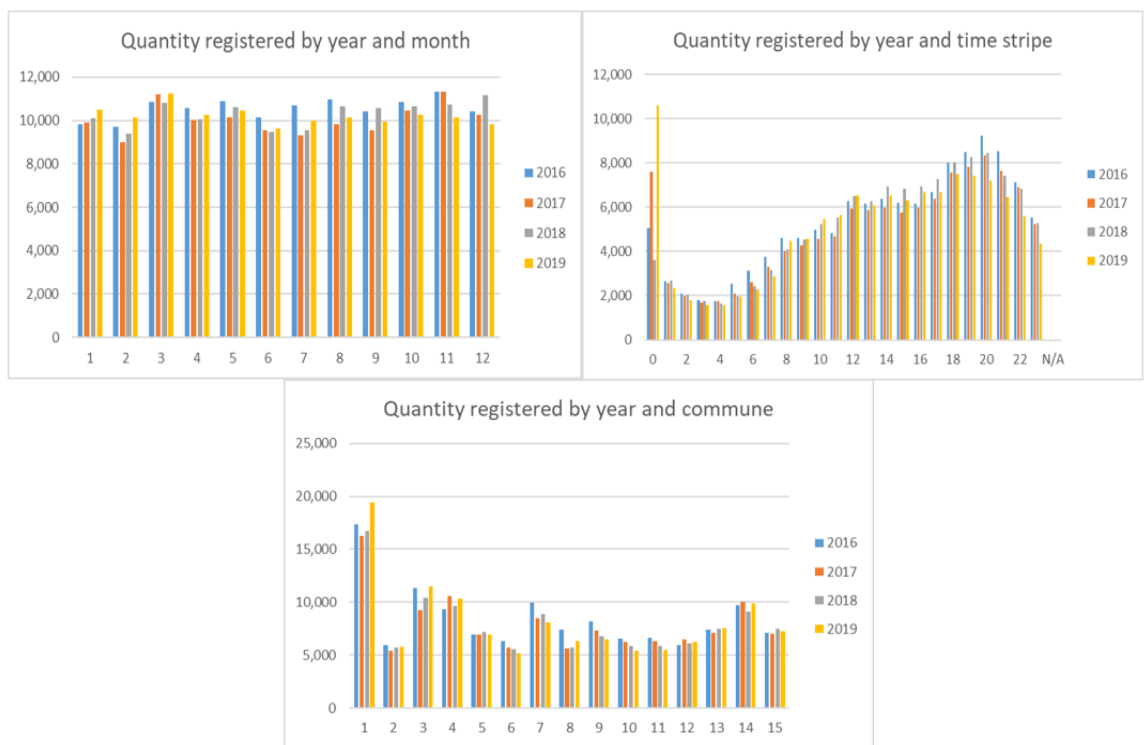
Figure 3. Amounts of crimes by year and month, by year and time zone, and by year and commune. Source: Author’s elaboration.